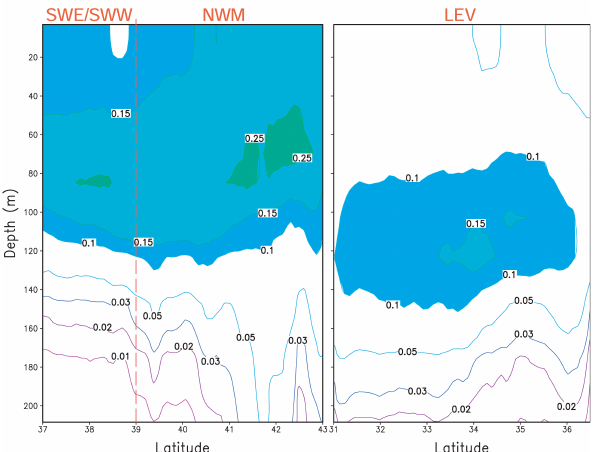
Fig. 4b. Vertical section of average chlorophyll (mgchl- a m − 3 ) from OPATM-BFM REF run along the T2 (left) and T4 (right) meridional transects (see Fig. 1) for the 6-yr period 1999–2004. Crossing lines between transect T2 and regions are indicated by dashed red lines.